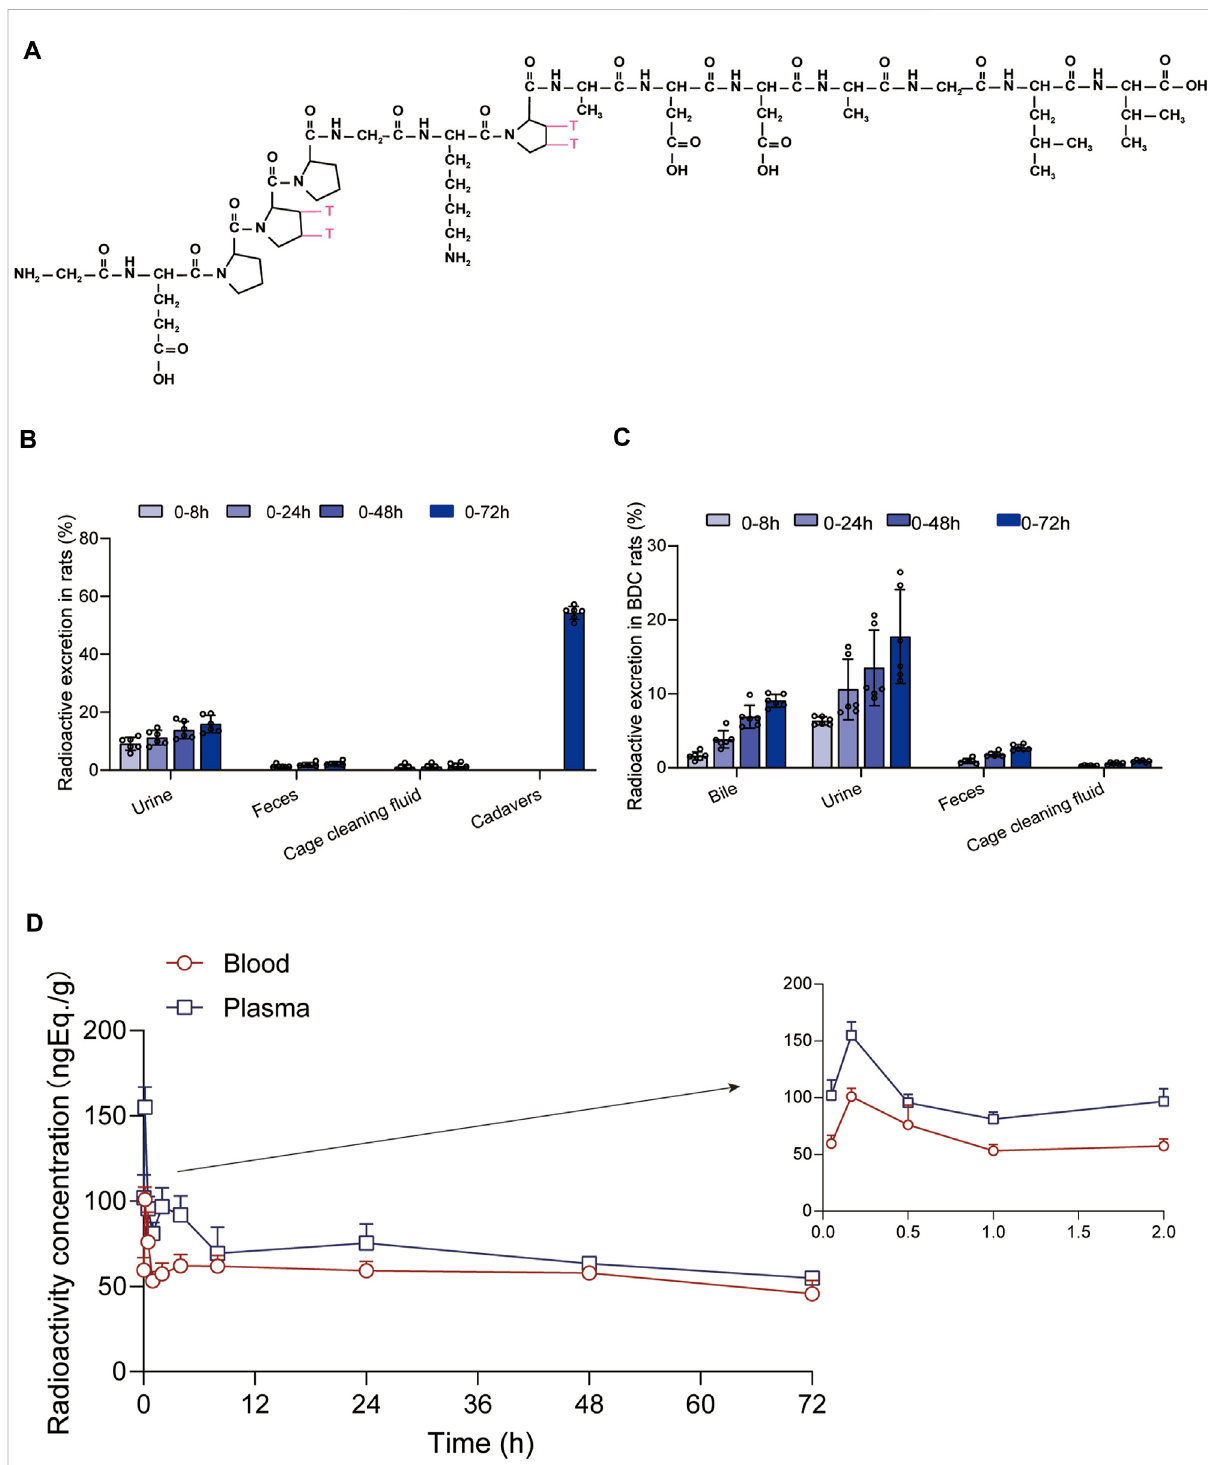
FIGURE 3 Evaluation of BPC157 excretion in rats by examination of total radioactivity. (A) The structure of [ 3 H]-labeled BPC157. [ 3 H]-labeled sites are indicated by T (red). (B) The average recovery of total radioactivity in the urine, feces, cage cleaning fl uid, and cadavers during 0 – 72 h after [ 3 H] BPC157 administration in intact rats (mean ± SD, n = 6). (C) The average recovery of total radioactivity in the urine, feces, and cage cleaning fl uid collected during 0 – 72 h after [ 3 H]BPC157 administration in bile duct cannulated rats (mean ± SD, n = 6). (D) Total radioactivity concentration versus time curve for [ 3 H]BPC157 in jugular vein cannulated rats following a single intramuscular injection at a dose of 100 µg/300 μ Ci/kg (mean ± SD, n = 6). Data are representative of three independent